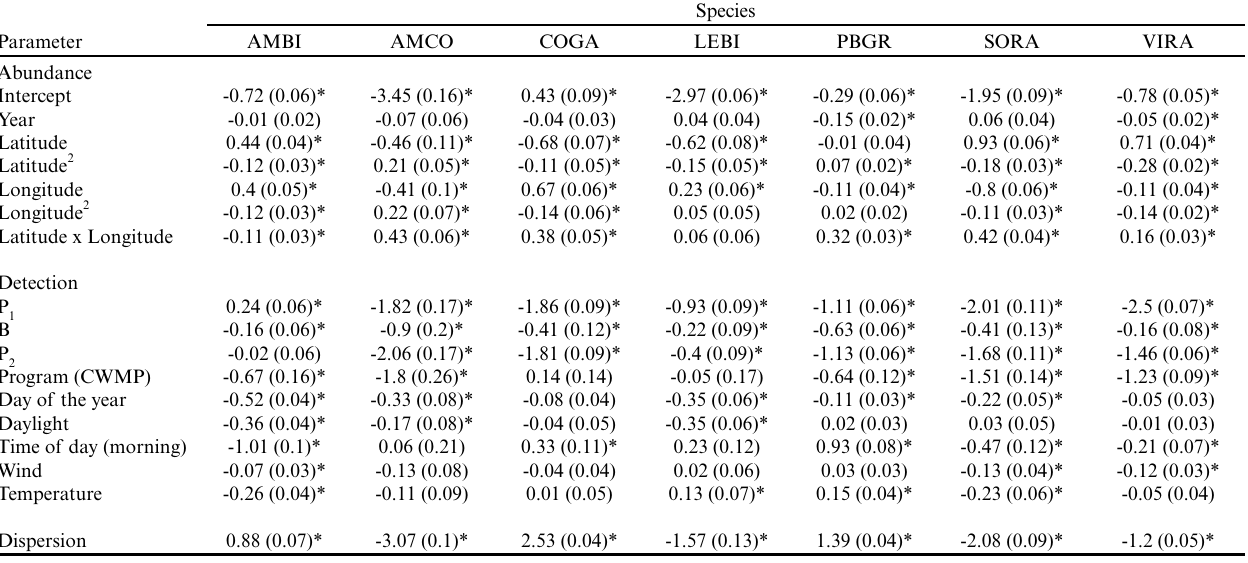
Table 1 . Parameter estimates from binomial N -mixture models used to assess the influence of call broadcast timing within point counts and survey duration on detection probability of marsh breeding birds throughout the Great Lakes–St. Lawrence region, 2008–2016. Standard error is given below each estimate in parentheses, with an asterisk indicating statistical significance at P < 0.05. P min passive observation period consisting of min 1–5, B = 5-min broadcast period consisting of min 6–10, P observation period consisting of min 11–15, CWMP = Coastal Wetland Monitoring Program, AMBI = American Bittern ( Botaurus lentiginosus ), AMCO = American Coot ( Fulica americana ), COGA = Common Gallinule ( Gallinula galeata ), LEBI = Least